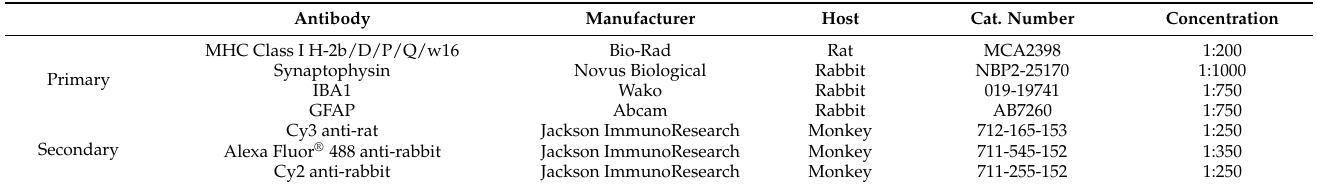
Table 1. Primary and secondary antibodies